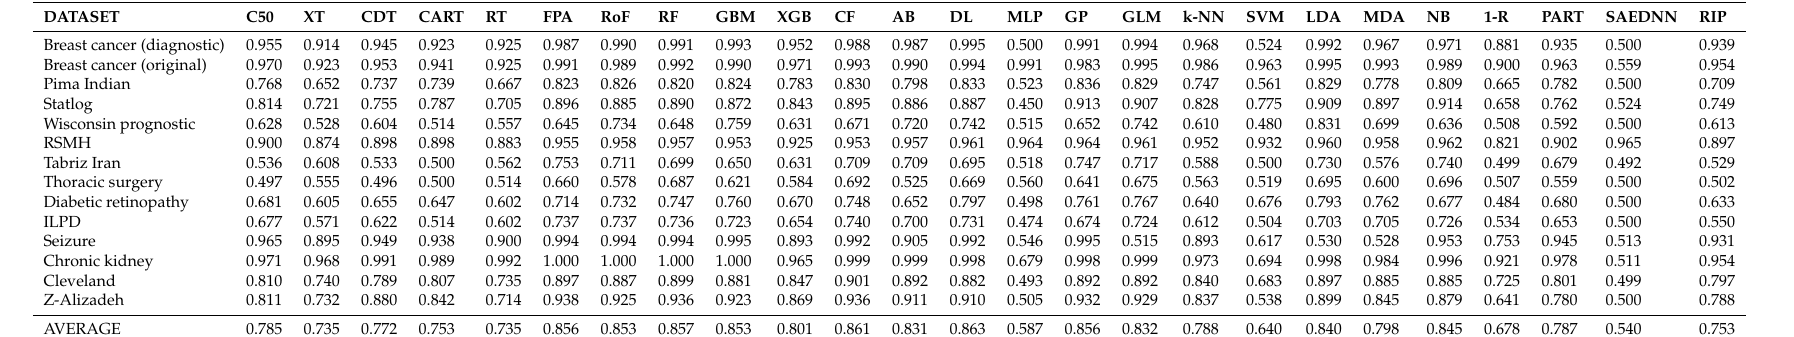
Table A2. Performance results of all classification algorithms w.r.t.